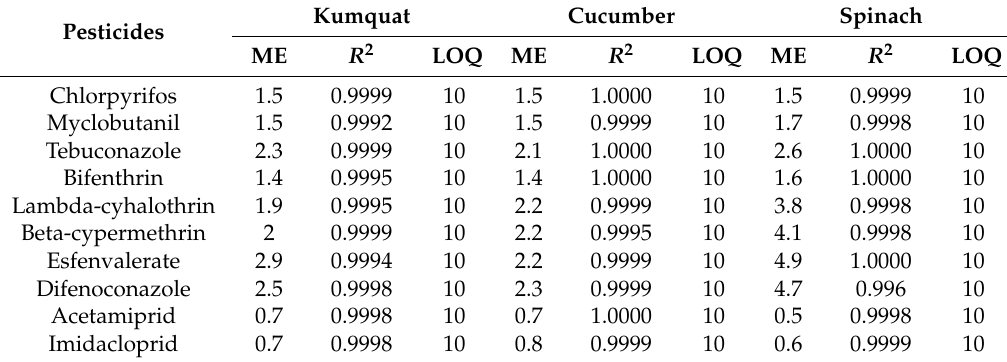
Table 4. Matrix effects (MEs), calibration curve coefficients ( R 2 ), and LOQs ( µ g/kg) for ten pesticides in kumquat, cucumber, and spinach ( n =